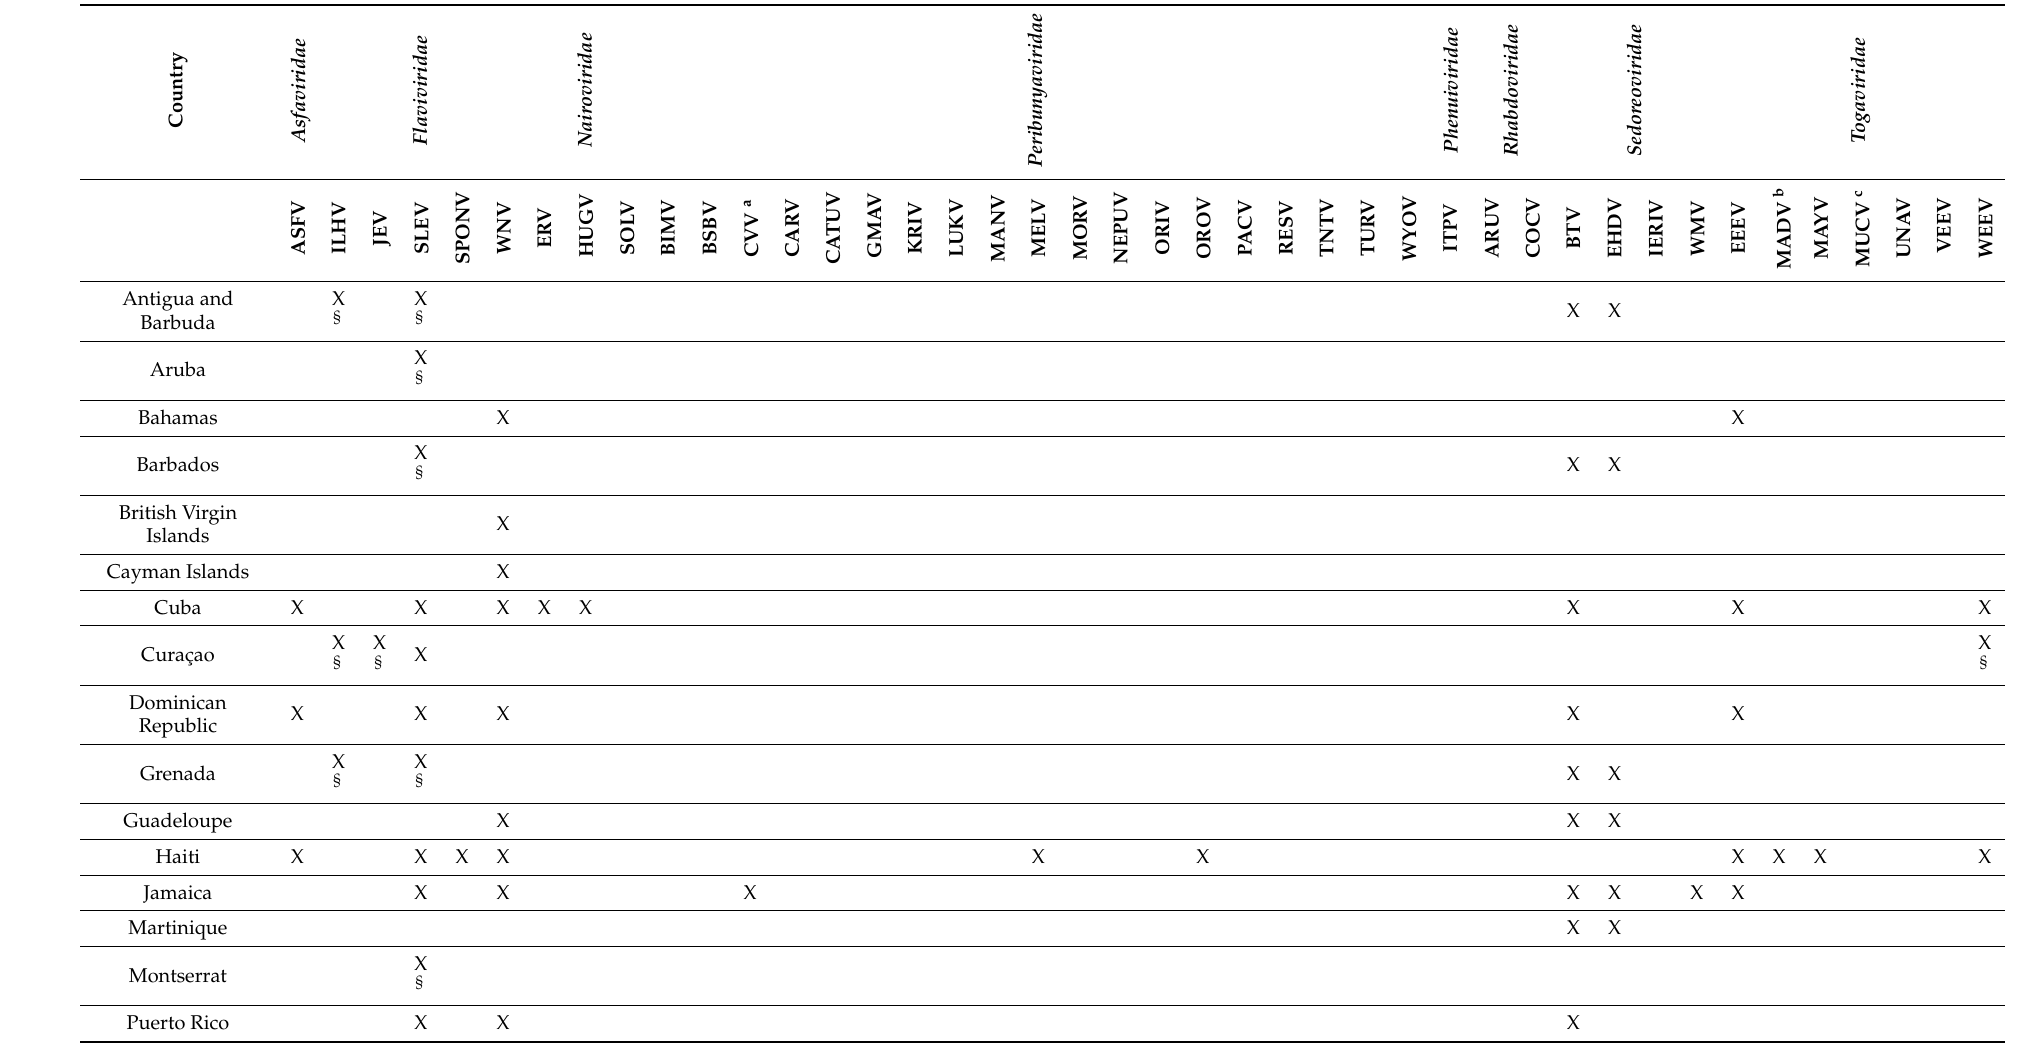
Table 2. Distribution of arboviruses in the islands of the